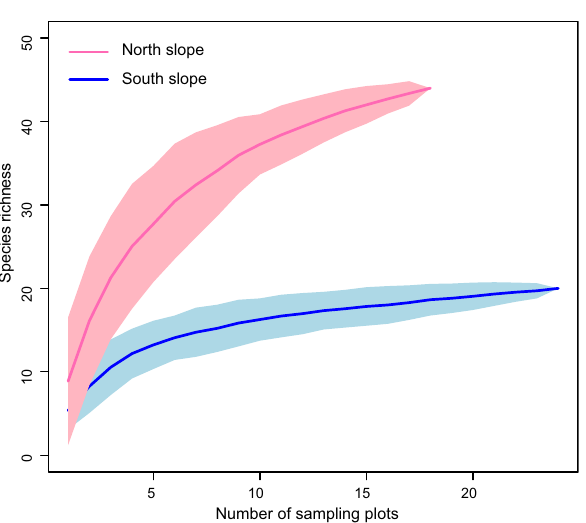
Figure 3. Gamma (γ) diversity with 95% confidence intervals for the north- (pink) and south-facing (blue) slopes based on sample-based rarefaction. North slope (N = 18), south slope (N =